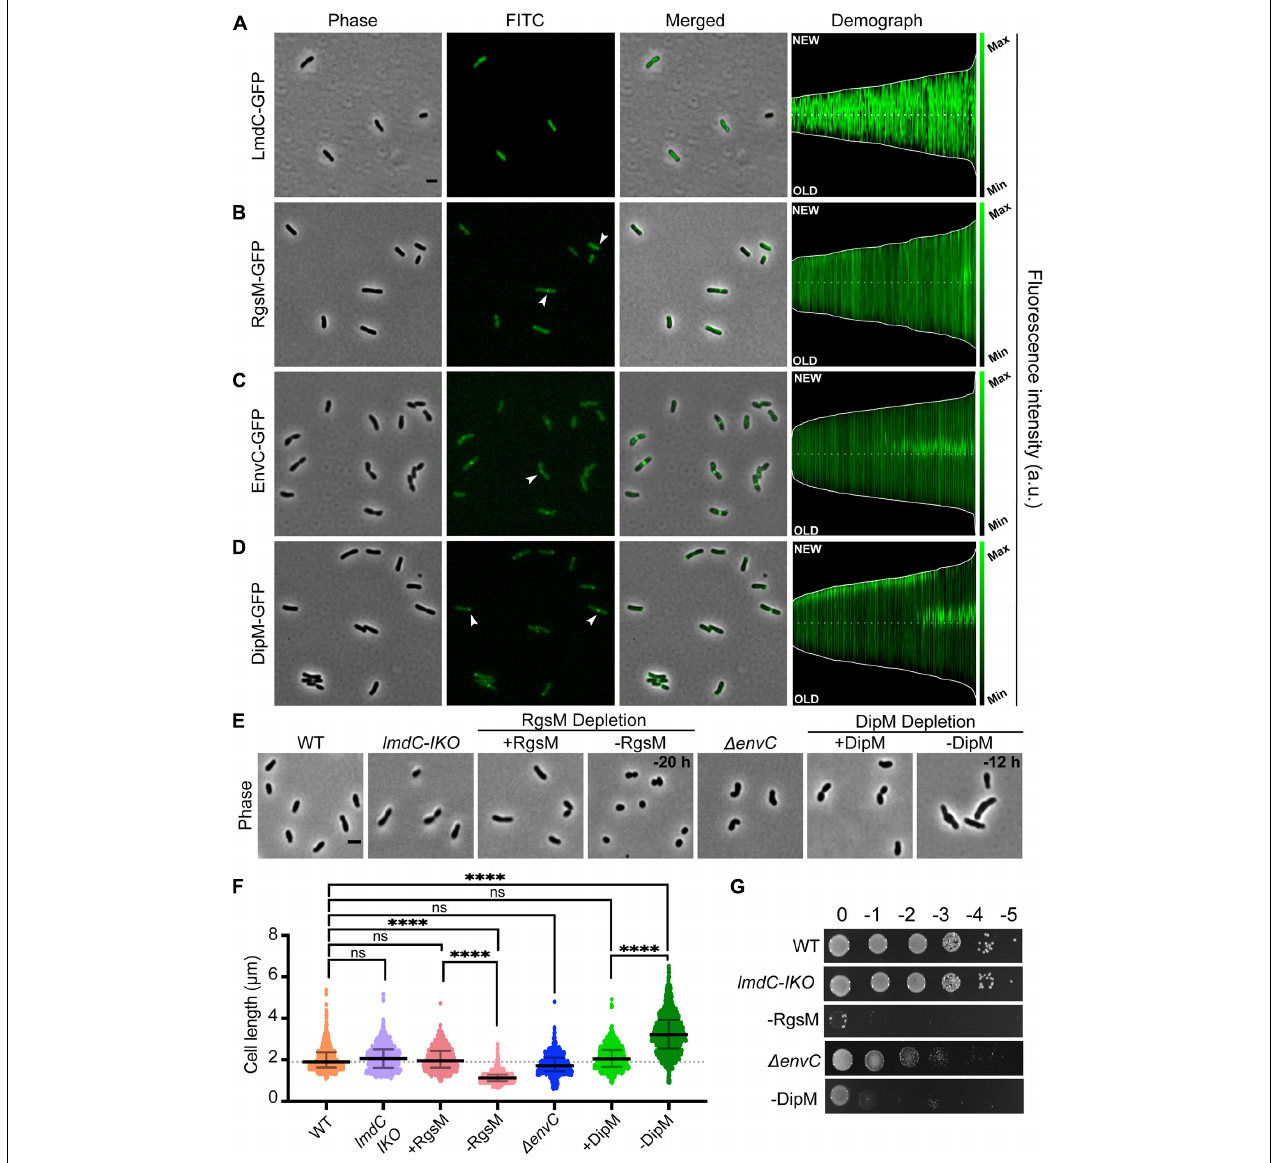
FIGURE 2 | Agrobacterium tumefaciens encodes four of the major LytM classes, each with distinct localization patterns and functional roles. ( A–D , left) Subcellular localization patterns for each LytM-domain containing factor in wildtype (WT) cells. Cells expressing either LmdC-GFP (Pcym-LmdC), RgsM-GFP (Pcym-RgsM), EnvC–GFP (PenvC-EnvC), or DipM-GFP (PT7-DipM) were grown to exponential phase (OD600 ∼ 0.6) and imaged by phase and fluorescence microscopy. Scale bar = 2 µ m. ( A–D , right) Demographs depict the localization of each LytM-domain containing factor at the population level. Median profiles of GFP channel of ∼ 100 to 500 cells per strain were stacked and ordered by cell length. “New” = active growth pole, “Old” = inert pole. (E) Phase contrast microscopy of representative strains. (F) Cell length distribution of indicated strains grown in liquid media. The cell length distribution is shown in scattered dot plots. The middle dash line represents the WT median cell length, the error bars represent the interquartile range of the population. **** P < 0.0001, ns, not significantly different. (G) Cell viability for each strain is shown by spotting serial dilutions. IKO indicates an insertional knockout strain. All data collected for this figure was obtained from cells grown in